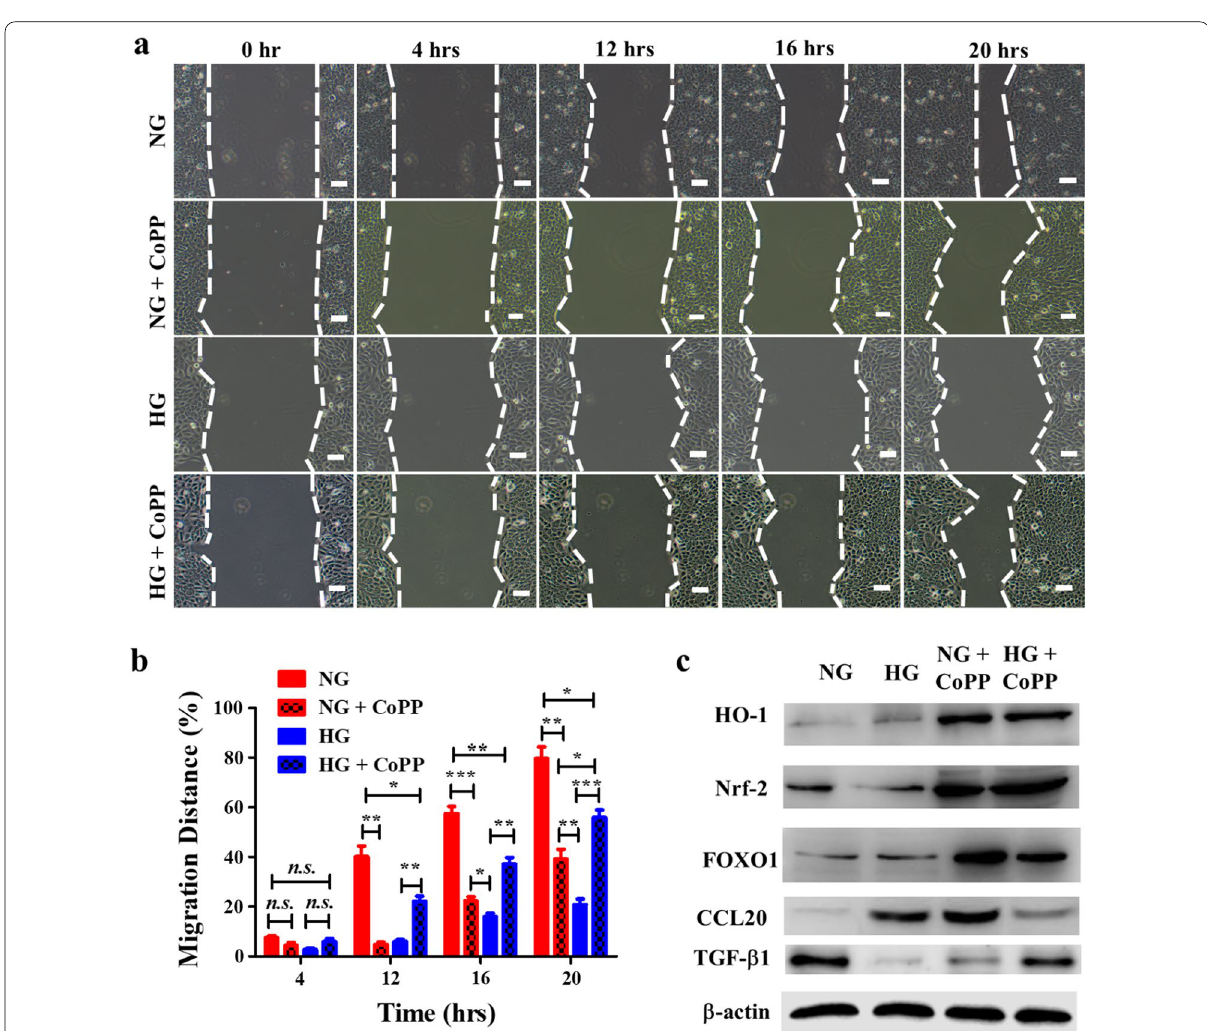
Fig. 3 The influence of CoPP on the motility of HaCaT in vitro wound healing assay. a Time lapse images showing the migrated distance of HaCaT after exposing to CoPP containing NG or HG media (scale bar, 100 μm), b ) and the statistical analysis. * P < 0.05; ** P < 0.01; *** P < 0.001. c Western blotting analysis of cell lysate harvested from the HaCaT that had been subjected to the wound healing